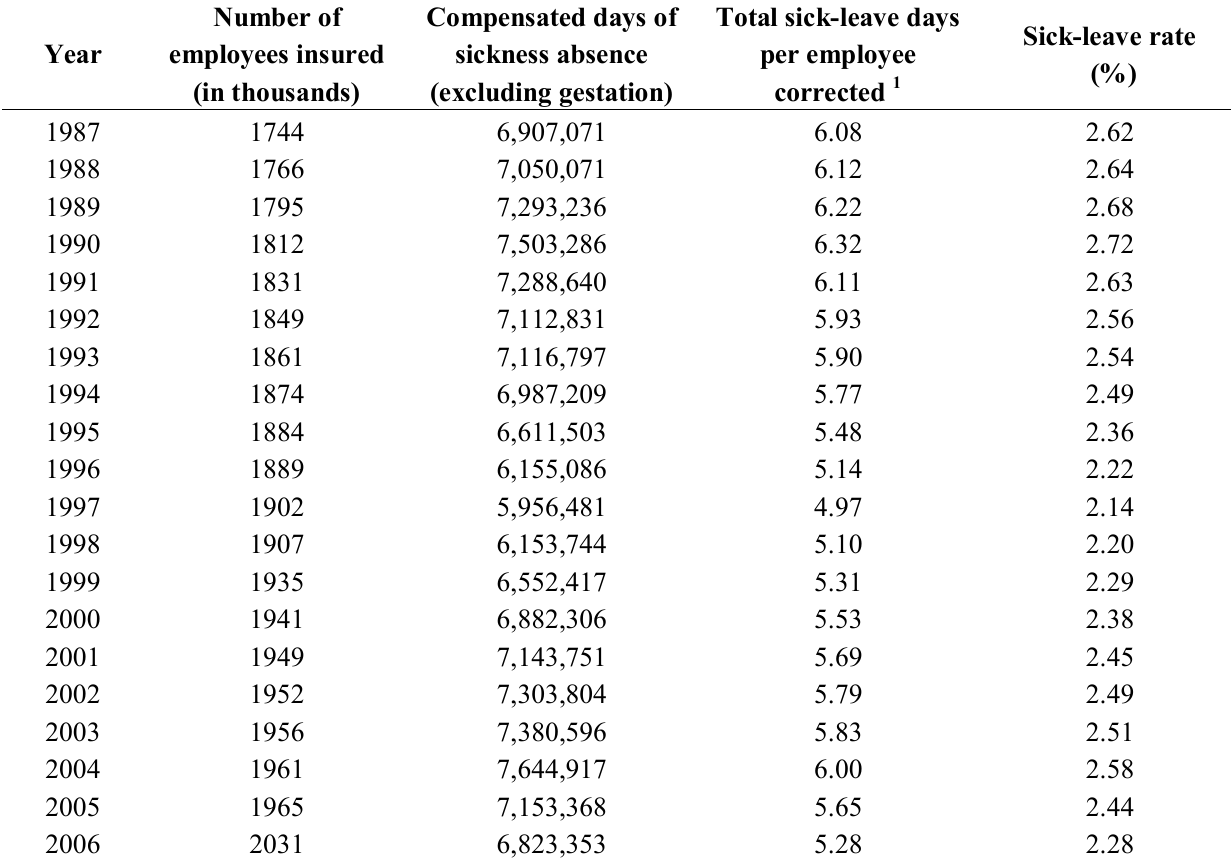
Table 1. Sickness absence in IKA insured employees (private sector) in Greece from 1987 to 2006.